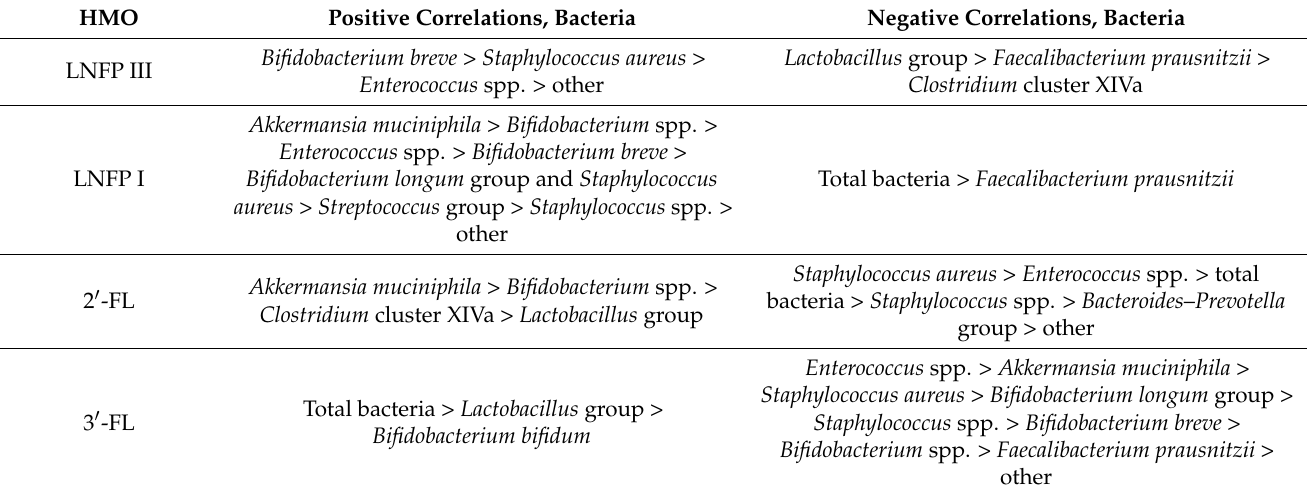
Table 1. Correlations between some human milk oligosaccharides and bacteria in colostrum (data from Aakko et al. [81]).